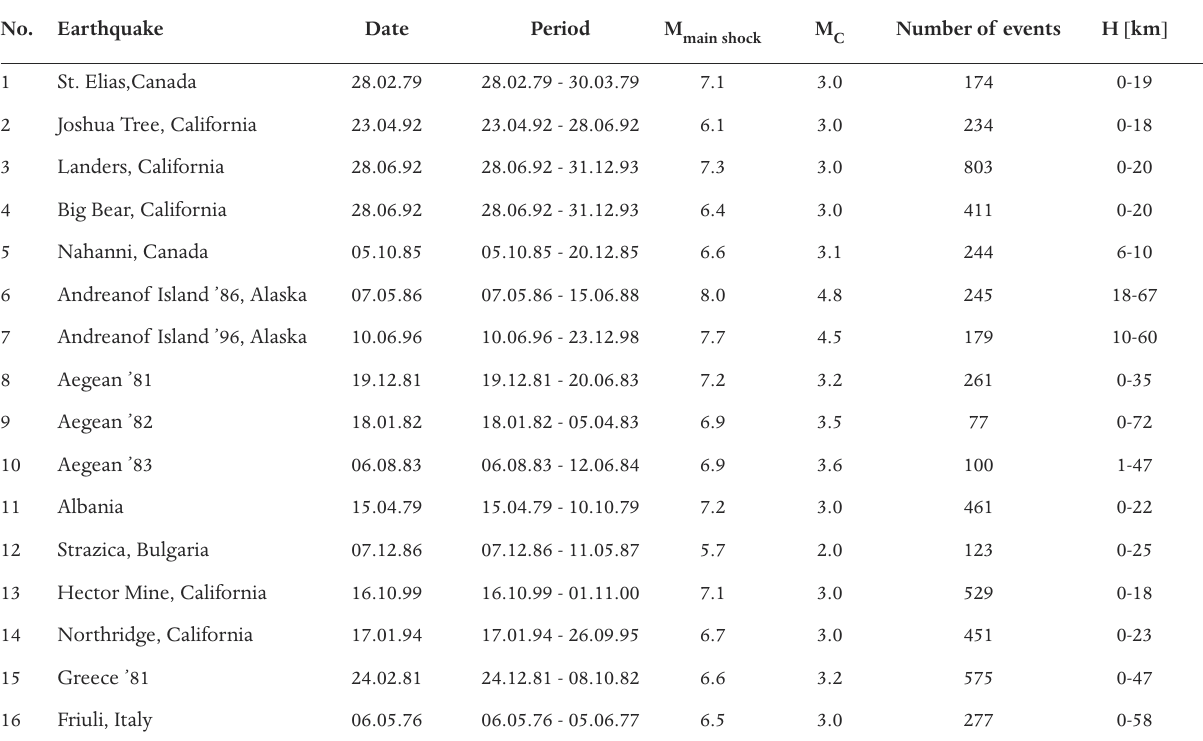
Table 1. Description of the studied aftershock series. M H is the depth interval for earthquakes in